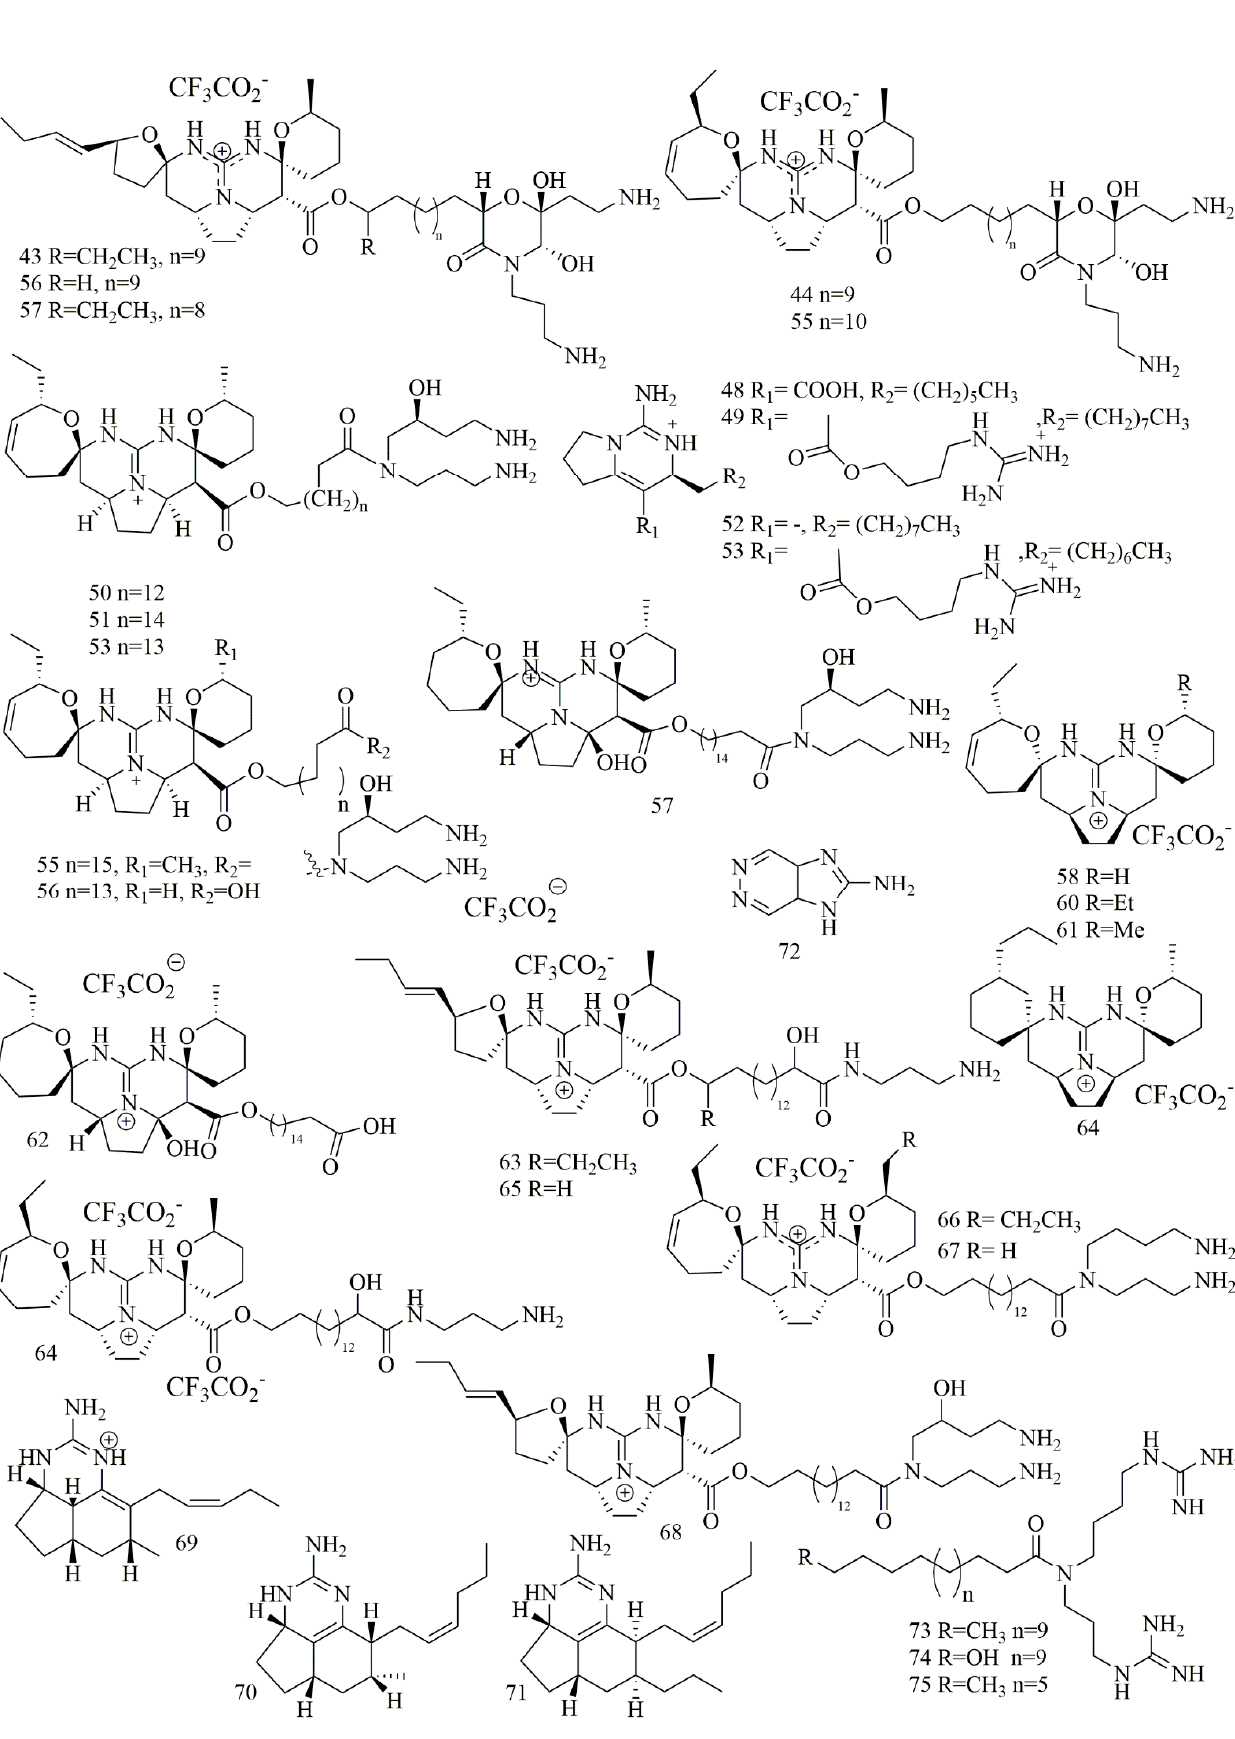
Figure 6. Guanidine alkaloids from marine sponges.